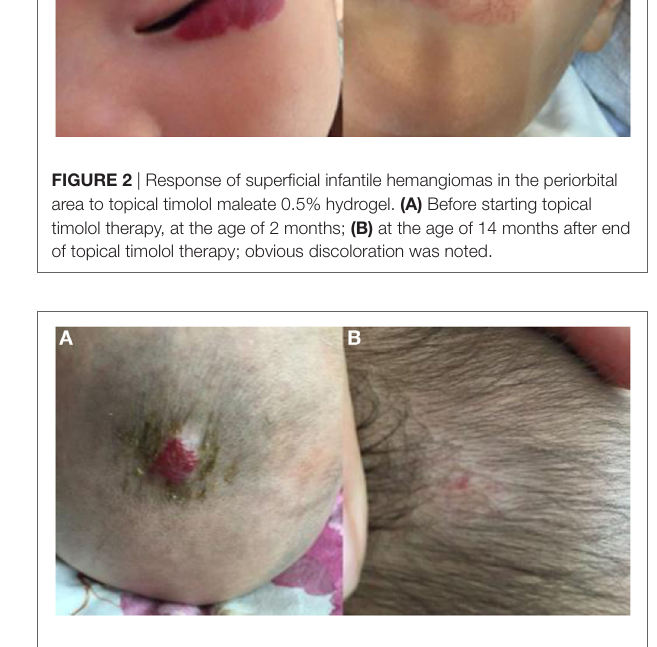
FigUre 3 | Response of superficial infantile hemangiomas in the scalp to topical timolol maleate 0.5% hydrogel. (a) Before starting topical timolol therapy, at the age of 5 months; (B) at the age of 13 months after end of topical timolol therapy; obvious discoloration and regression in size were noted.